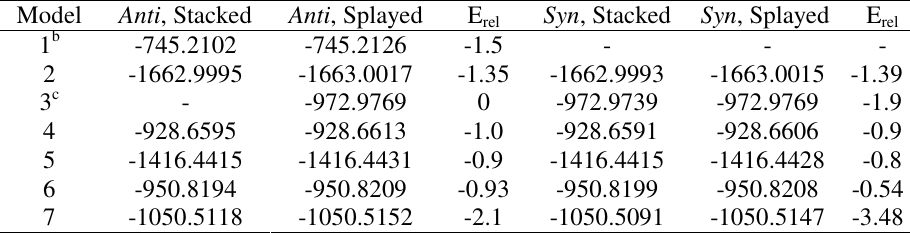
Table 2. Energies of stacked and splayed conformers